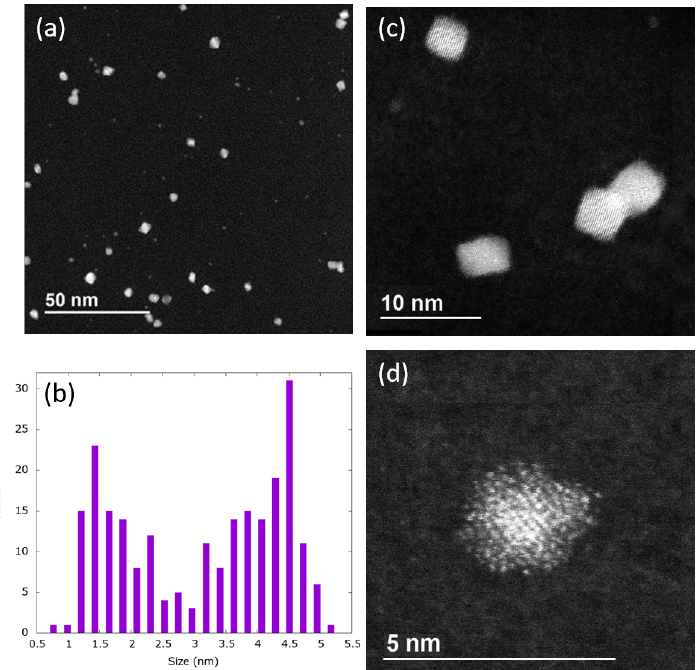
Figure 1. Bimodal distribution of PtPd NPs. ( a ) Low-magnification C s -corrected STEM-HAADF image showing several NPs. ( b ) Histogram showing the size distribution of the NPs. ( c , d ) Specimens representing the two